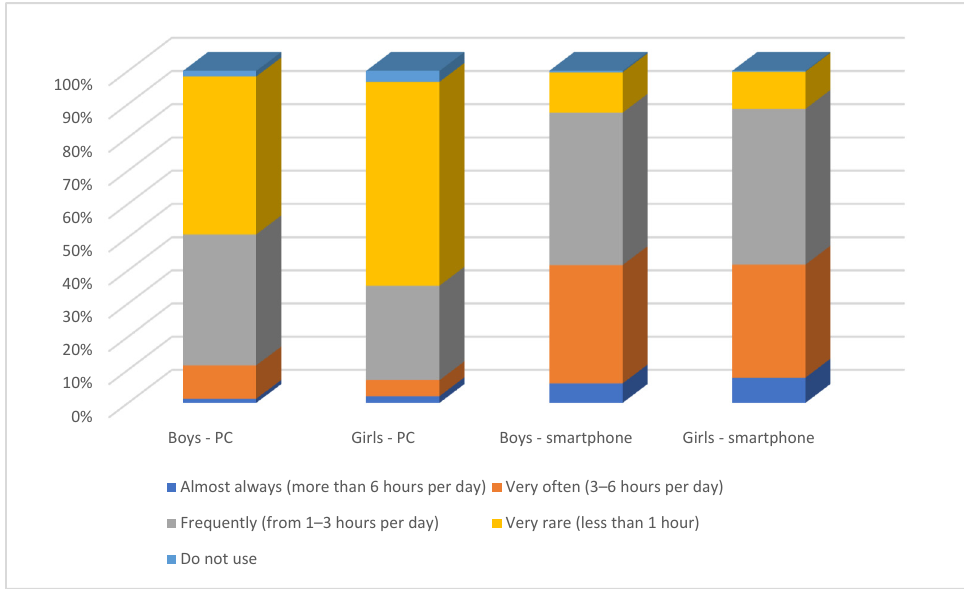
Figure 2. Exposure to internet via smartphone and PC by gender.